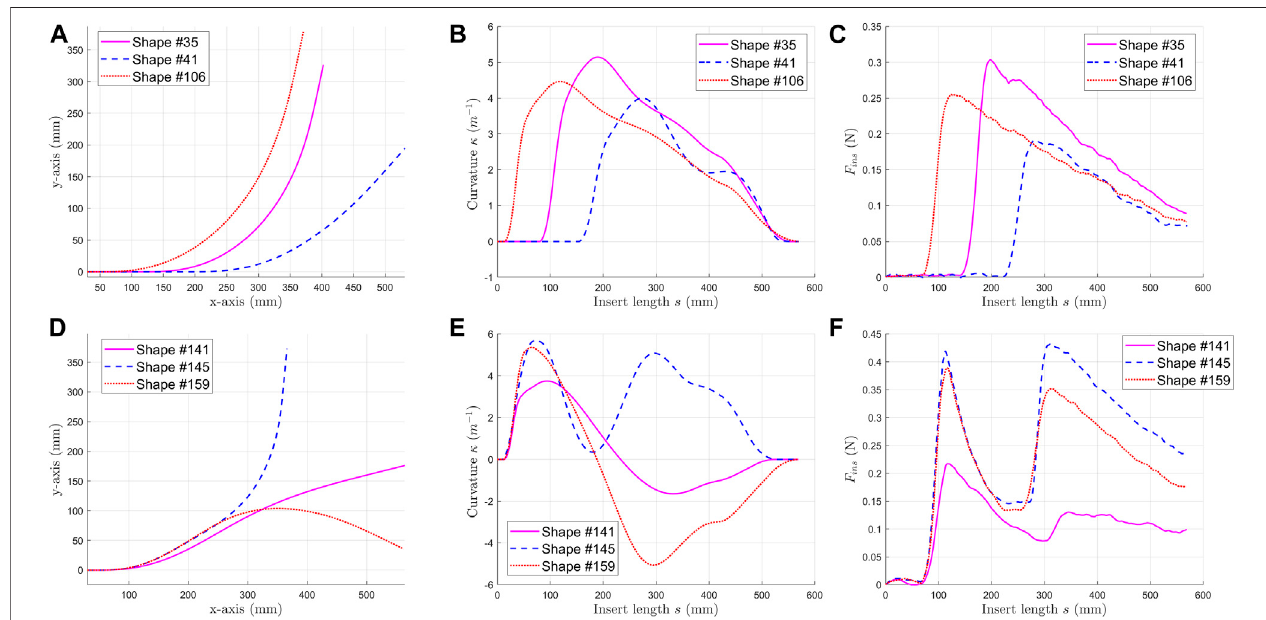
FIGURE 6 | Some examples of data collected. For one-bend shape #35, #41j: (A) coordinates of the channel shapes, (B) curvature of the channel shapes, (C) insertion forces of the selected shapes. For one-bend shape #141, #145 Ÿ : (D) coordinates of the channel shapes, (E) curvature of the channel shapes, (F) insertion forces of the selected shapes.